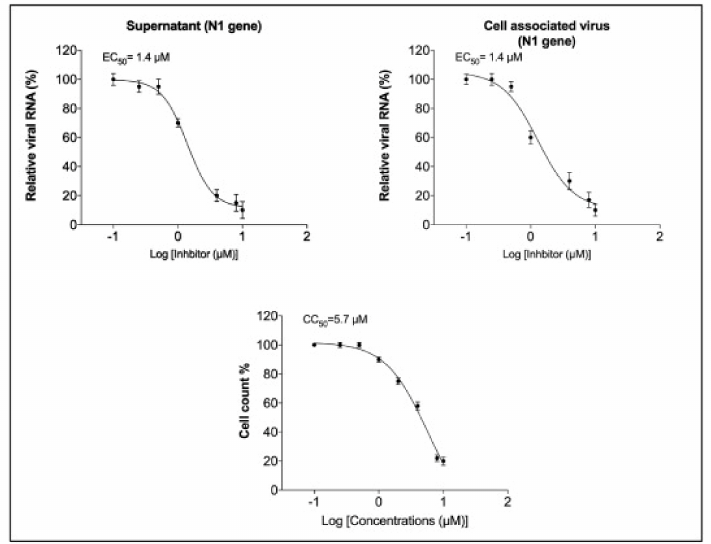
Figure 8. Auranofin-treated cells have a dose-dependent decrease in SARS-CoV-2 RNA: Auranofin (0.1–10 µ M) was applied to SARSCOV-2 infected Huh7 cells in repeated dilutions. RT-PCR was used to quantify viral RNA in cell pellets and culture supernatants using primers and probes targeting the SARS-CoV-2 N1. The data were graphed using a non-linear regression model (GraphPad software). Auranofin reduced virus replication in infected cells with an EC50 of about 1.4 µ M. The 50% cytotoxic concentration was around 5.7 µ M. The data represent two separate tests that were carried out in duplicate, with permission from [134].